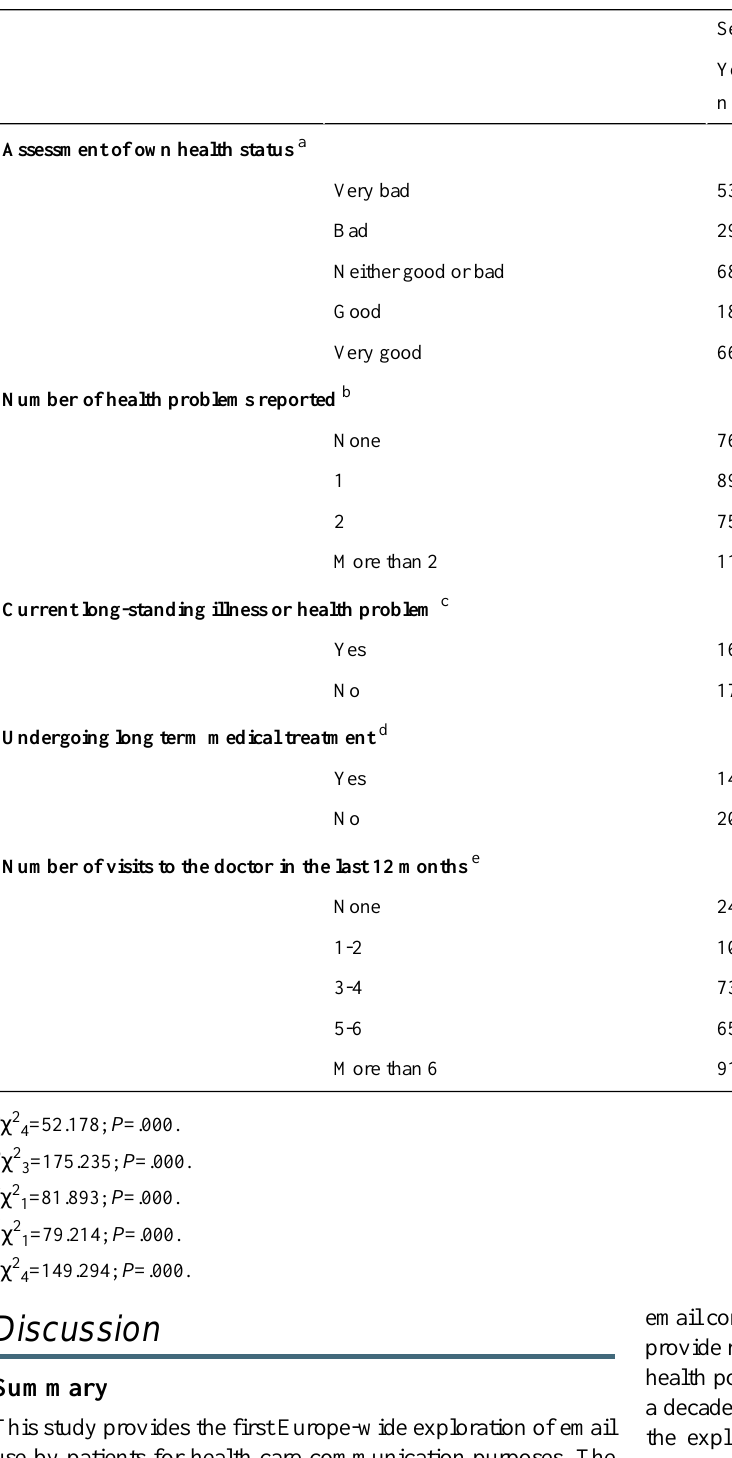
Table 6. Sent/received an email from your doctor, nurse, or health care organization, by health status and health care